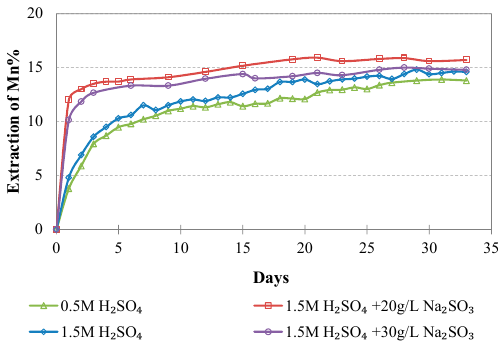
Figure 11. Evolution of % Mn extraction vs time during LAI leaching for different tests.